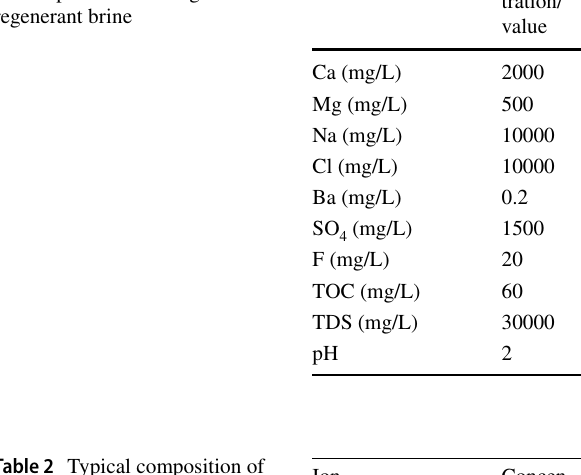
Table 1 Typical composition of the spent ion exchange regenerant brine